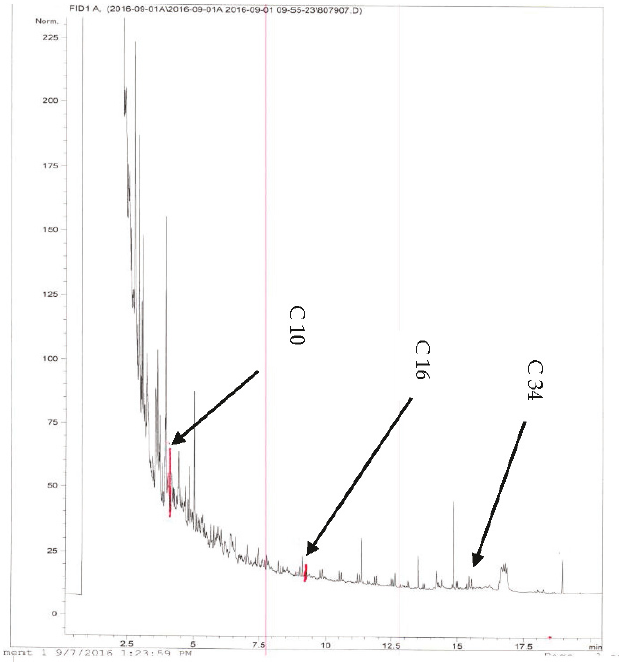
Figure 15. C 10 , C 16 and C 34 GC-FID.